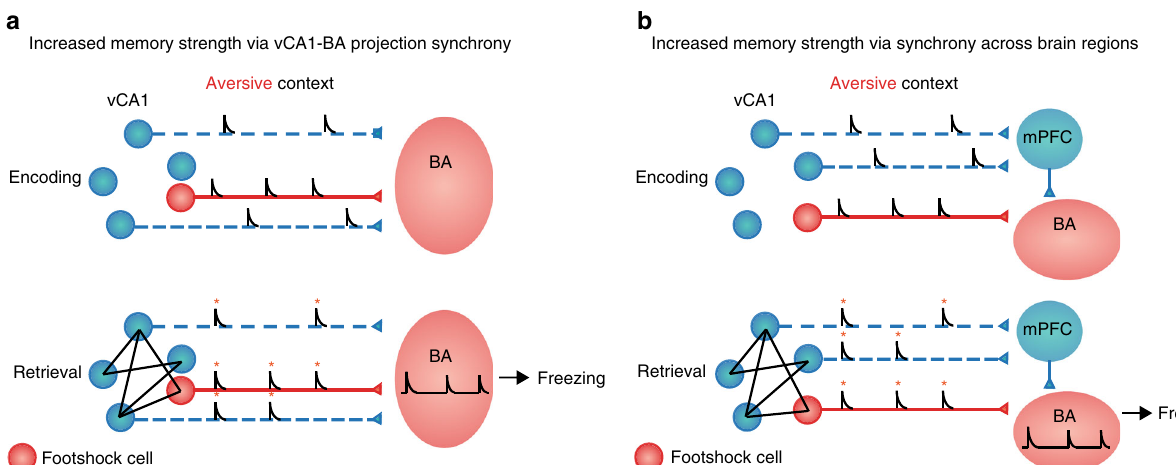
Fig. 5 Putative mechanisms for vCA1 shock cell-dependent memory retrieval. Putative mechanism for vCA1 shock cell correlation-mediated memory retrieval. a vCA1 shock cells (red) and their correlated A2 partners (blue) represent vCA1-BA projecting neurons, and their synchronized Ca 2 + transients during retrieval (bottom) results in coincident synaptic release within the BA to facilitate fear expression and induce freezing behavior. b vCA1 shock cells (red) represent vCA1-BA projecting neurons and their correlated A2 partners represent a separate vCA1 projection with indirect projections to the amygdala, such as the vCA1-mPFC projection (blue). Synchronized Ca 2 + transients between vCA1-BA (shock cells) and vCA1-mPFC projections results in coincident synaptic release within the amygdala to facilitate fear expression and induce freezing